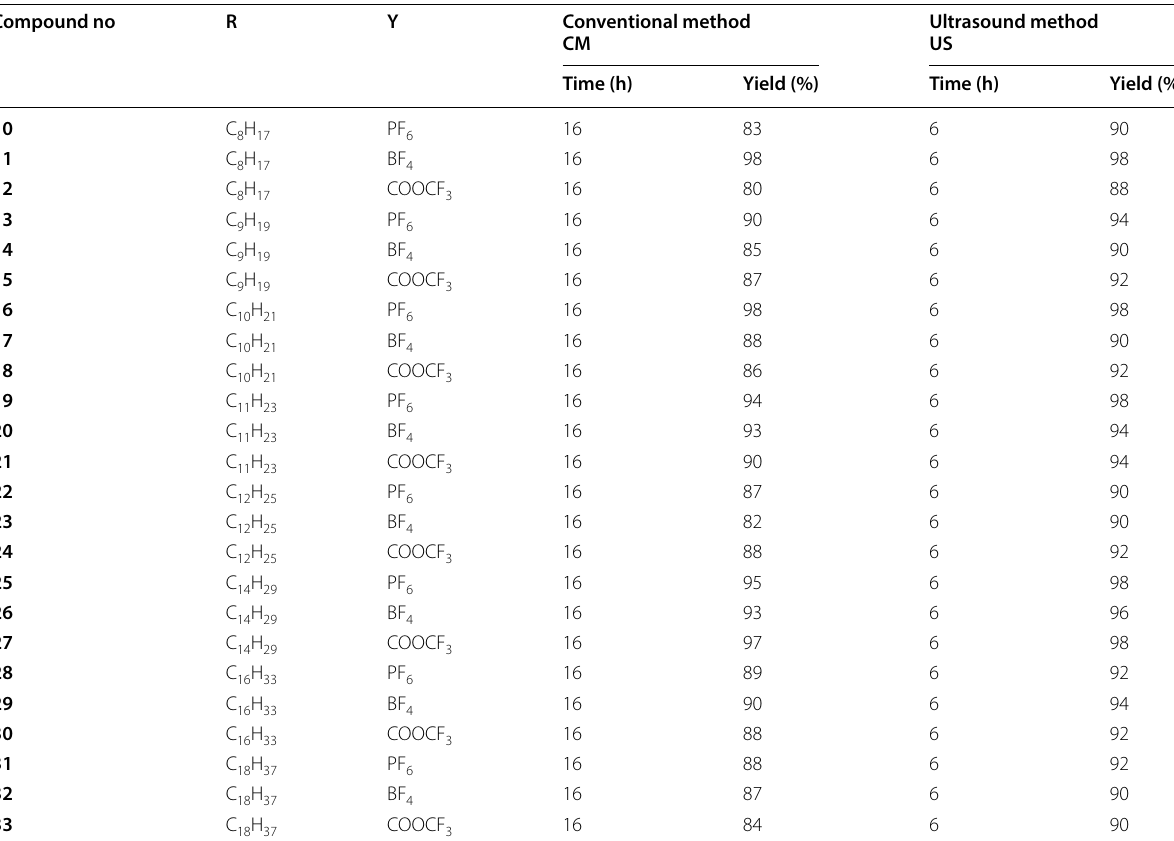
Table 2 Times and yields of pyridinium hydrazones 10–33 carrying fluorinated counter anions under conventional and